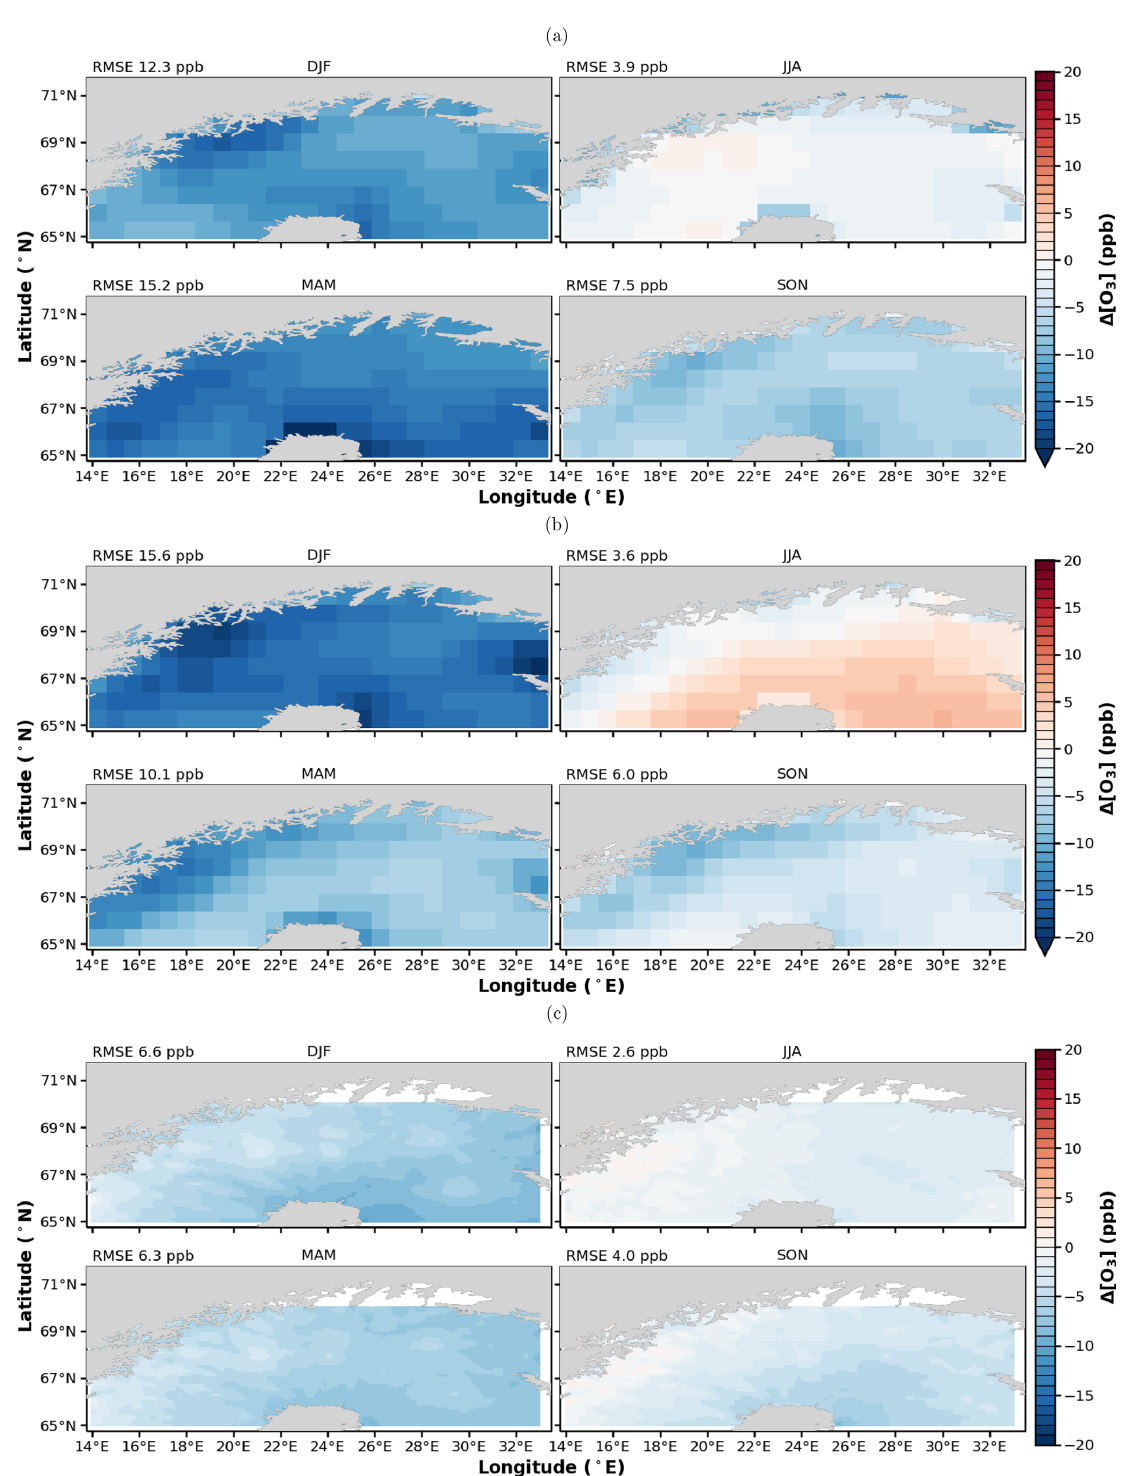
Figure 4. Deviation of reanalysis products from generalized ozone climatology for northern Fennoscandia: (a) MACC, (b) CAMS, and (c) CAMSRAQ. Negative (positive) values indicate that the reanalysis product underestimates (overestimates) the ground-level back- ground [ O 3 ] . Shown are seasonal averages: December–January–February (DJF), June–July–August (JJA), March–April–May (MAM), and September–October–November (SON). The RMSE has been computed over land only and is displayed in the upper left corner of each